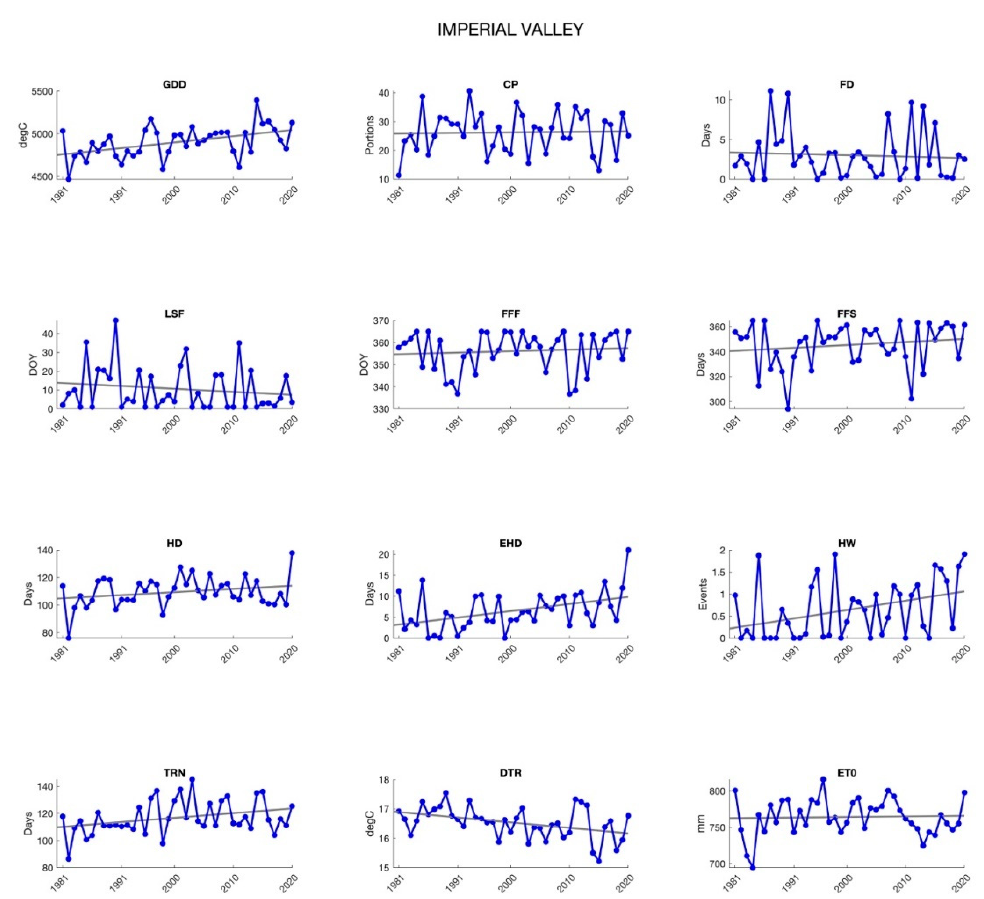
Figure A7. Annual agroclimate metrics averaged over the Imperial Valley region with linear trendline.